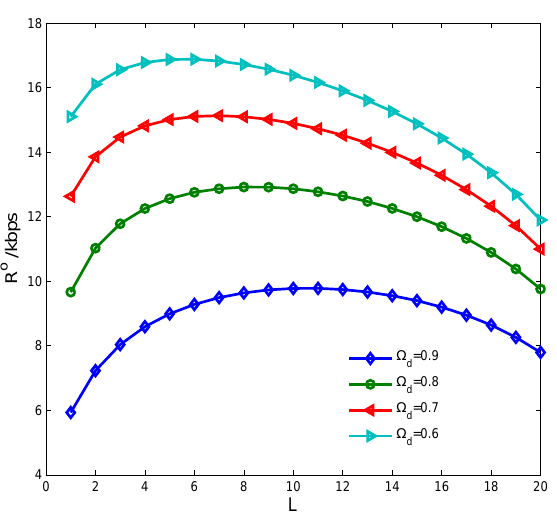
Figure 13. Transmission rate vs. cooperative detection probability with number of sensing cognitive sensors.